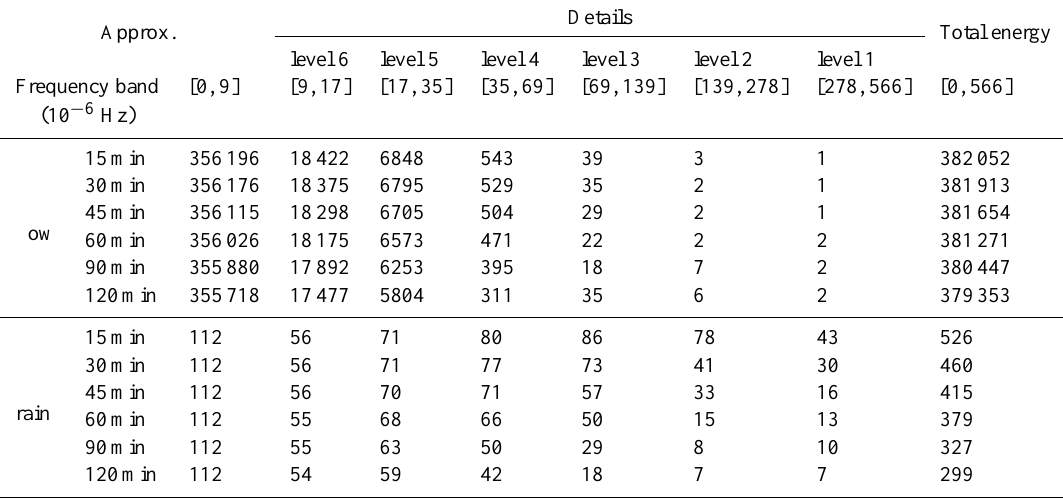
Table 5. Energy distributions in different frequency bands for 1yr rainfall–runoff observations with different sampling intervals of 15, 30, 45, 60, 90 and 120min. Approx.